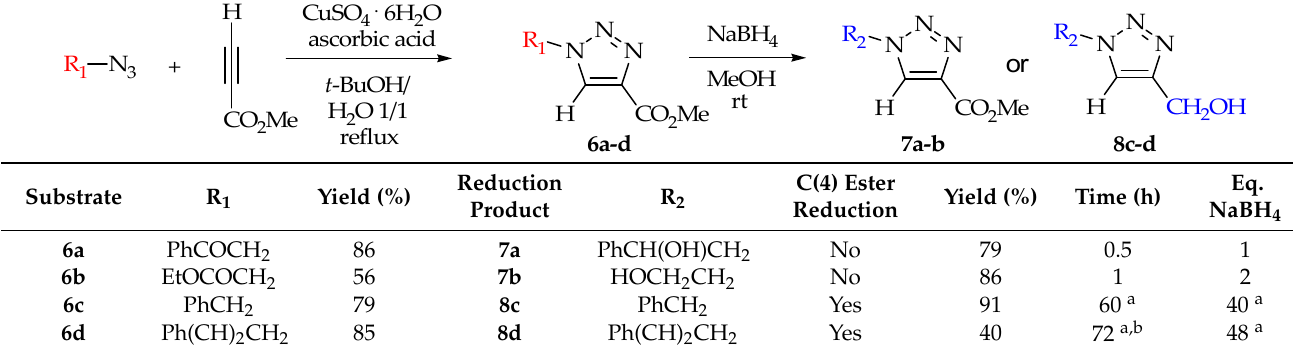
but the reduction of the C(4) position ester group of 8c – d was slow and required multiple days and a large excess of NaBH 4 , as shown in Table 3. Table 3. Preparation and reduction of methyl 1-substituted 1 H -1,2,3-triazole Table 3. Preparation and reduction of methyl 1-substituted 1 H -1,2,3-triazole carboxylates.